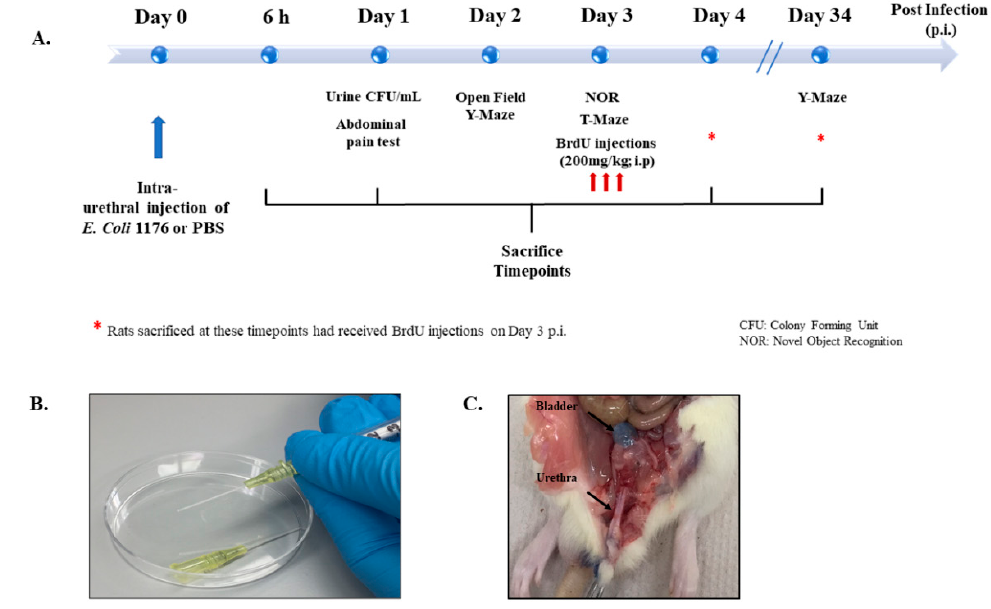
Figure 1. Experimental design and settings. ( A ) Schematic showing the experimental timeline followed for behavioral tests, BrdU injections, and sacrifice. ( B ) Image showing the catheters and syringes used for intraurethral injections in the study. ( C ) Image showing the anatomical location of trypan blue intraurethral instillation in the bladder of a rat used for trial. Table 1. Experimental groups as per treatments and sacrifice time points.